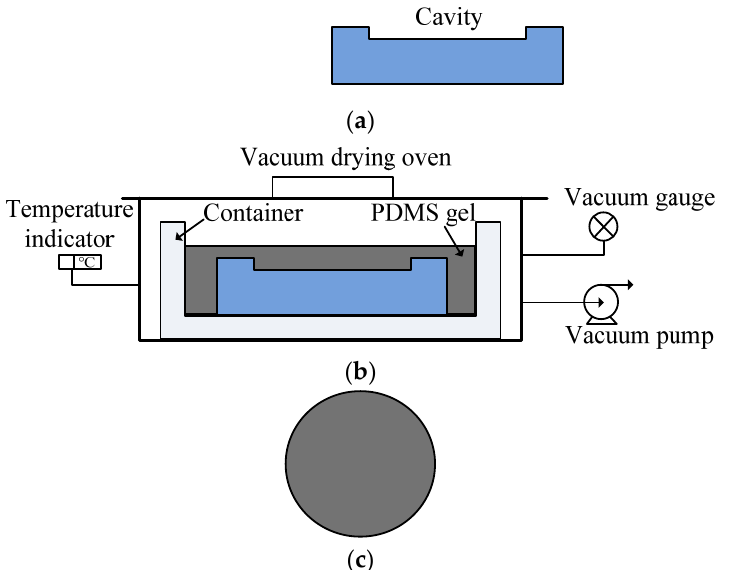
Figure 2. Schematic diagram of preparation process of PDMS film: ( a ) The stainless steel mold with cavity is prepared; ( b ) PDMS gel is filled into the mold in the vacuum chamber; ( c ) PDMS film layer is cured and removed from the mold.